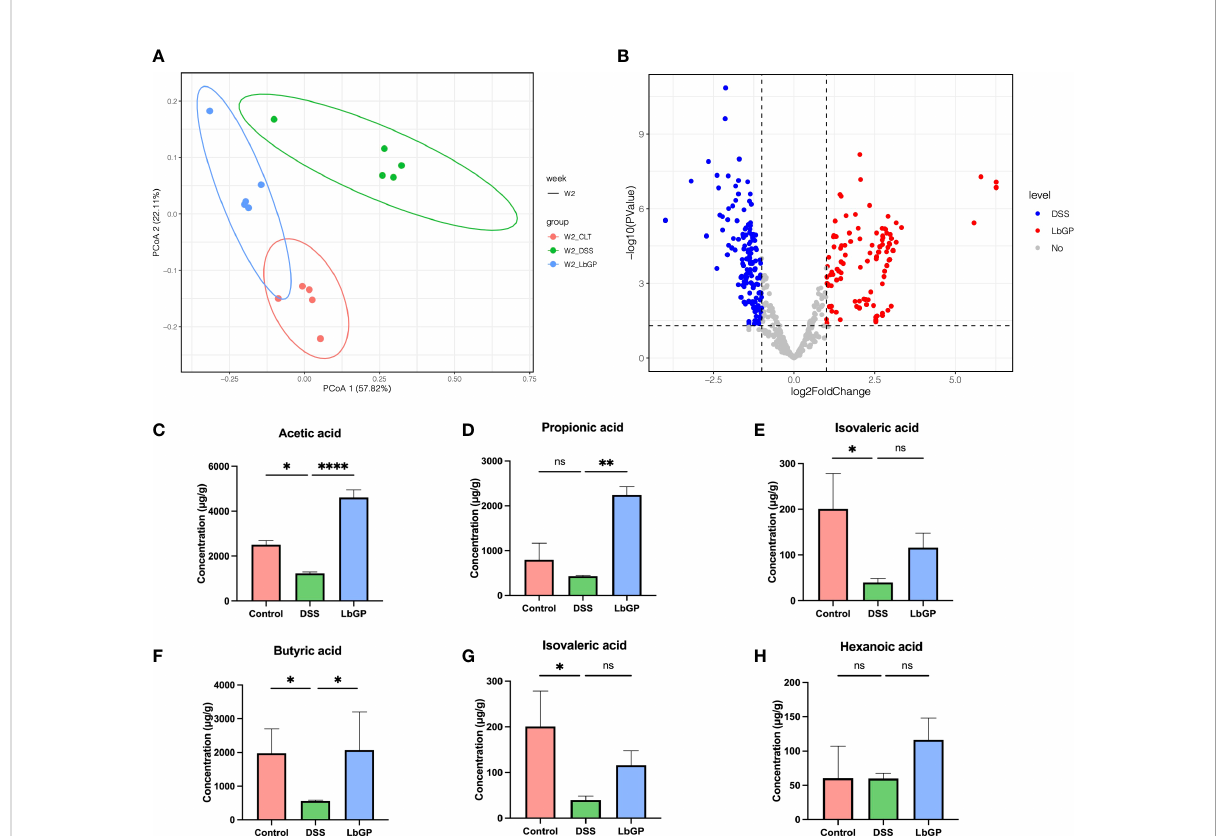
FIGURE 7 LbGP altered the function of gut microbiota. (A) PCoA analysis of metagenomic function based on the Bray-Curtis distance at W2. (B) Volcano plot of differential KOs between the DSS group and LbGP group at W2. (C – H) Concentrations of different SCFAs in mice colonic contents at W2. (n = 5, *P < 0.05, **P < 0.005, ****P < 0.0001). “ ns ” means “ no signi fi cant ”